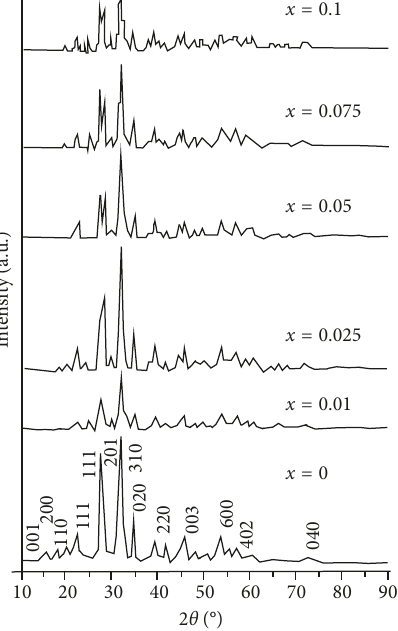
Figure 1: X-ray diffraction patterns of TlFe heat treatment at a temperature of 933 K and for 500h exposure time. T � 298K.